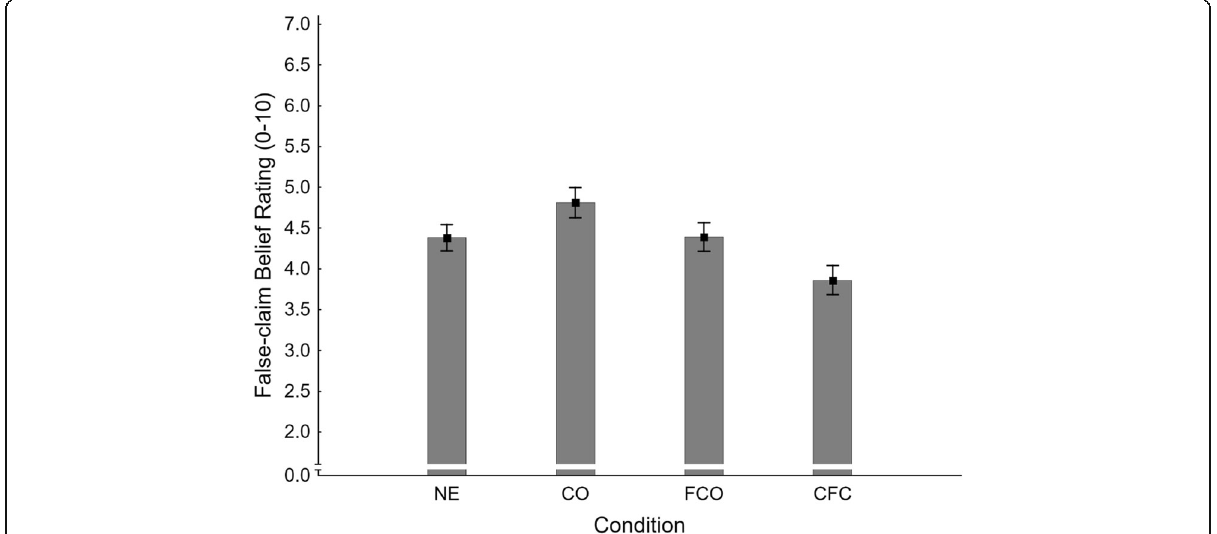
Fig. 4 Mean false-claim belief ratings across conditions NE (no-exposure), CO (claim-only), FCO (fact-check-only), and CFC (claim-plus-fact-check) in Experiment 1. Error bars show standard errors of the